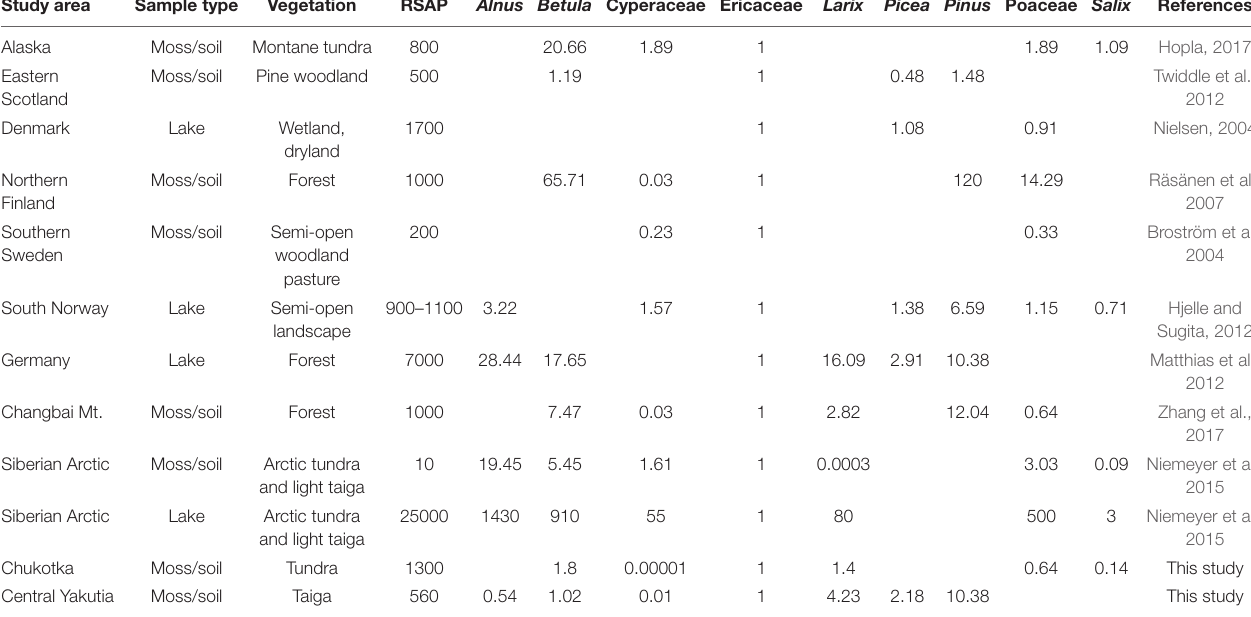
TABLE 5 | Relative pollen productivity (RPP) estimates rescaled relative to Ericaceae (RPPs from Changbai Mt. and Germany were rescaled based on the relationship between their original reference taxa and Ericaceae in this study) in previously published studies for selected taxa that are compared with this study. Study